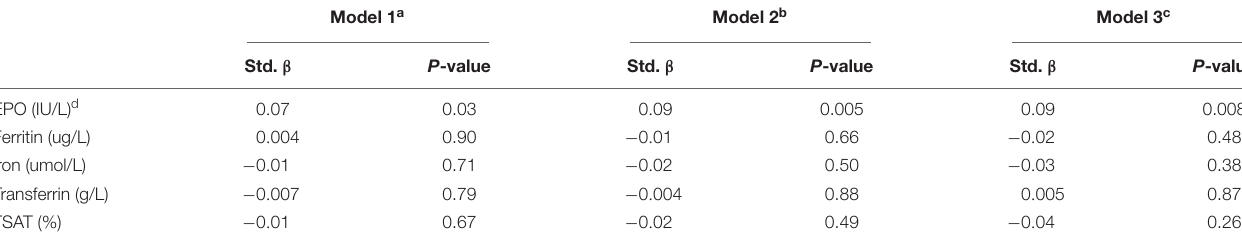
TABLE 4 | Multivariate linear regression analyses of the association of individual iron status parameters and erythropoietin with RFFT score.